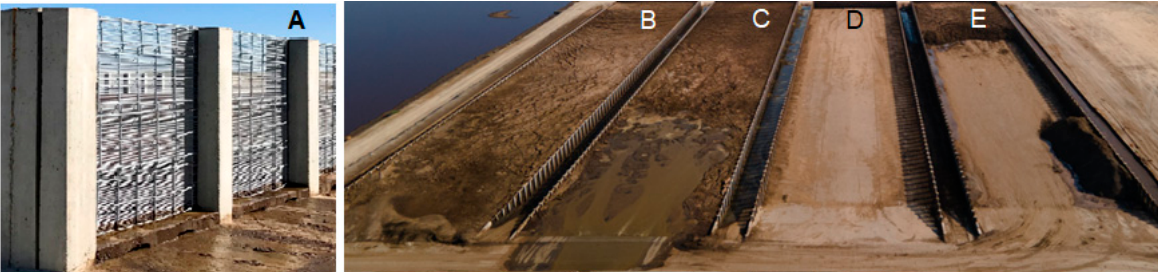
Figure 4. Weeping wall cells under different phases: ( A ) side of a weeping wall, ( B ) under drying cell, ( C ) under filling cell, ( D ) empty cell, and ( E ) under emptying